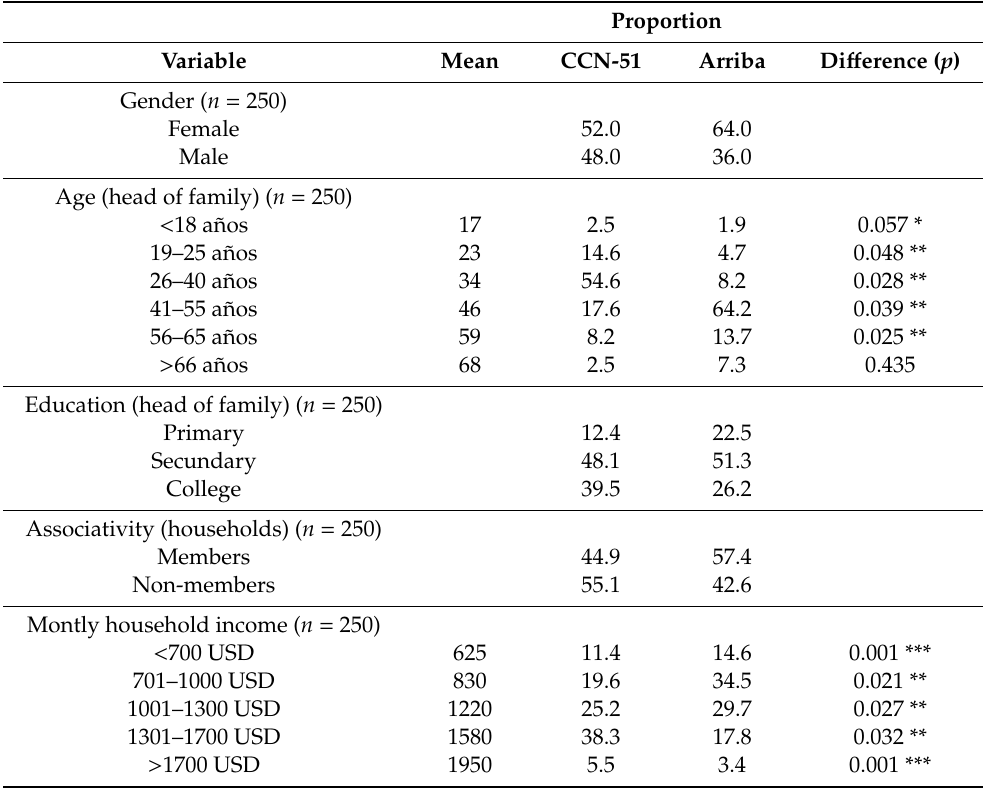
Table 3. Socio-economic characteristics of cocoa-producing